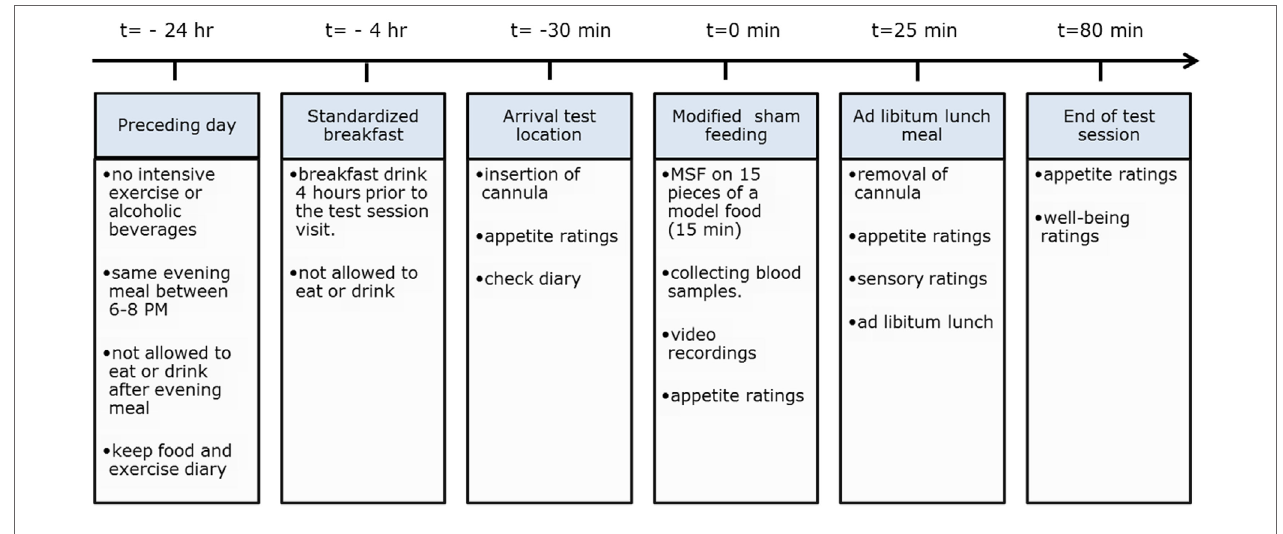
FigUre 2 | Overview of experimental